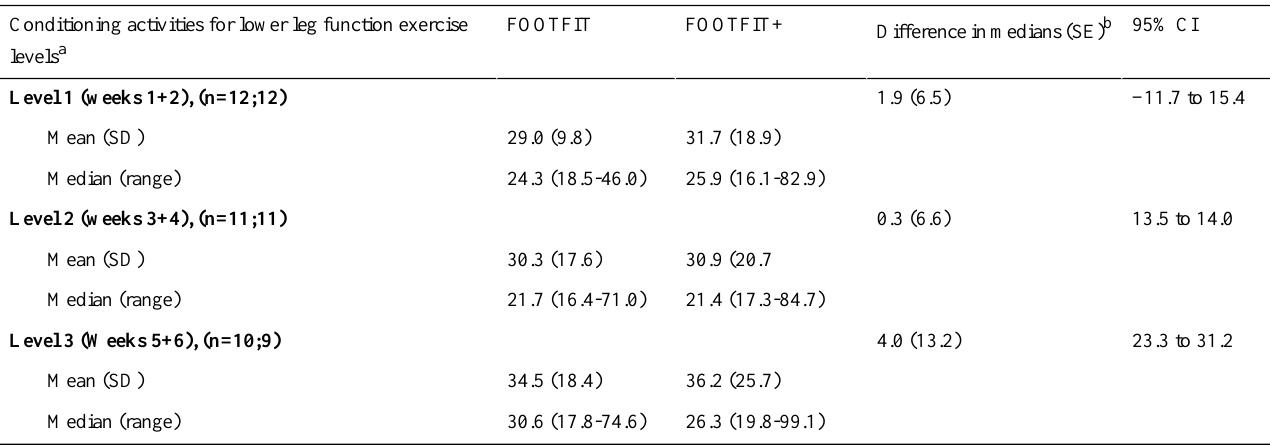
Table 4. Mean (SD) and median (range) exercise duration in seconds by exercise level for FOOTFIT and FOOTFIT+ groups.